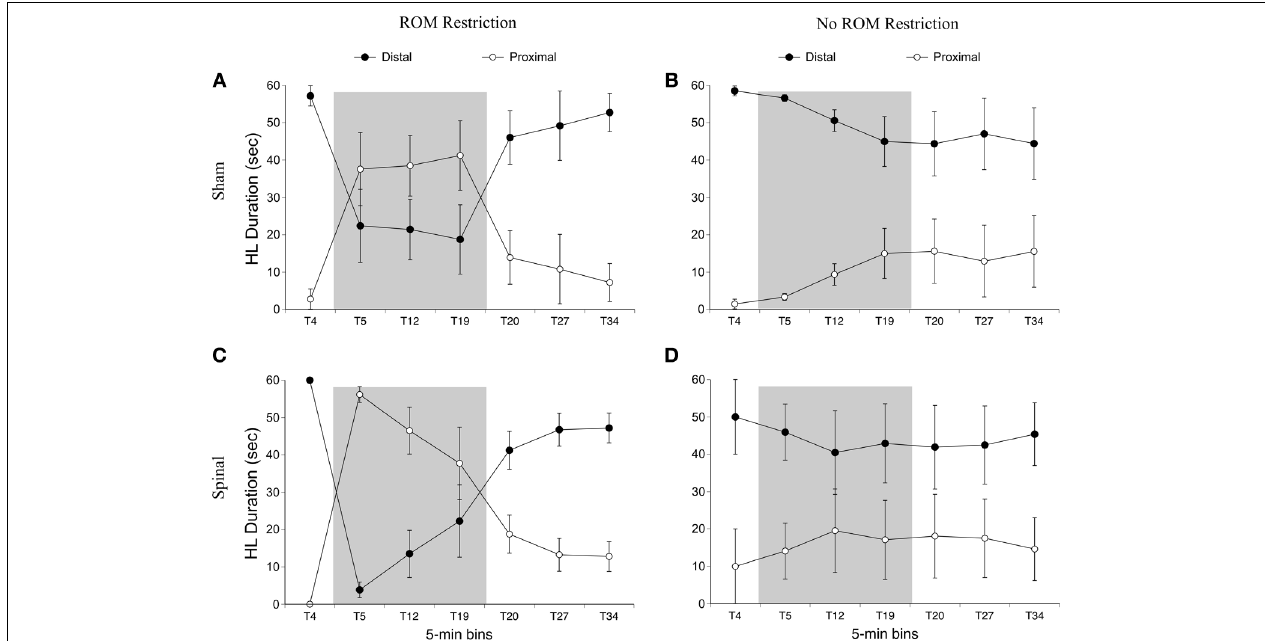
FIGURE 8 | Dorsal-ventral hindlimb trajectories for sham and spinal rats by ROM restriction condition. Graphs show duration of time spent in distal and proximal trajectory areas for 1-min sections during baseline, ROM restriction, and the post-ROM restriction period for (A) sham subjects that